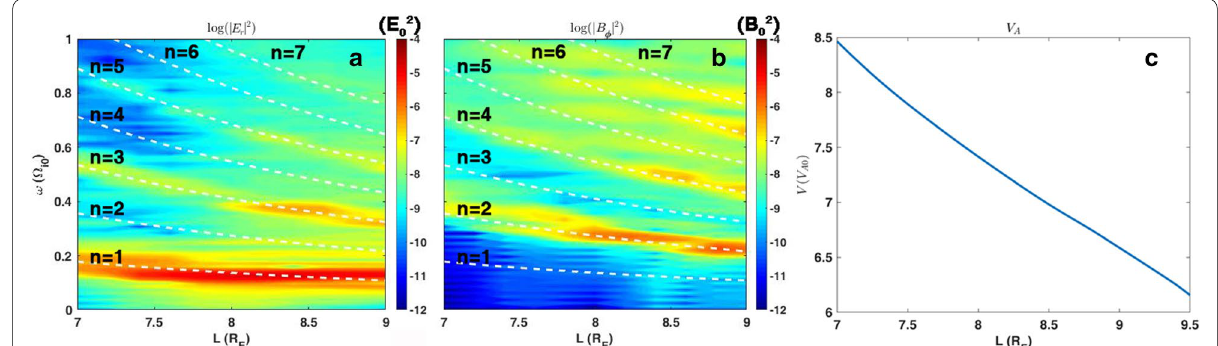
Fig. 14 Case II: radial profiles of wave power spectra of a E r and b B φ as a function of L in the noon-meridian plane. The white dashed lines mark the first 7 harmonic modes of the FLRs. The white dashed traces are the field line eigenfrequency profiles of the first 7 harmonics. The local Alfvén speed is shown in